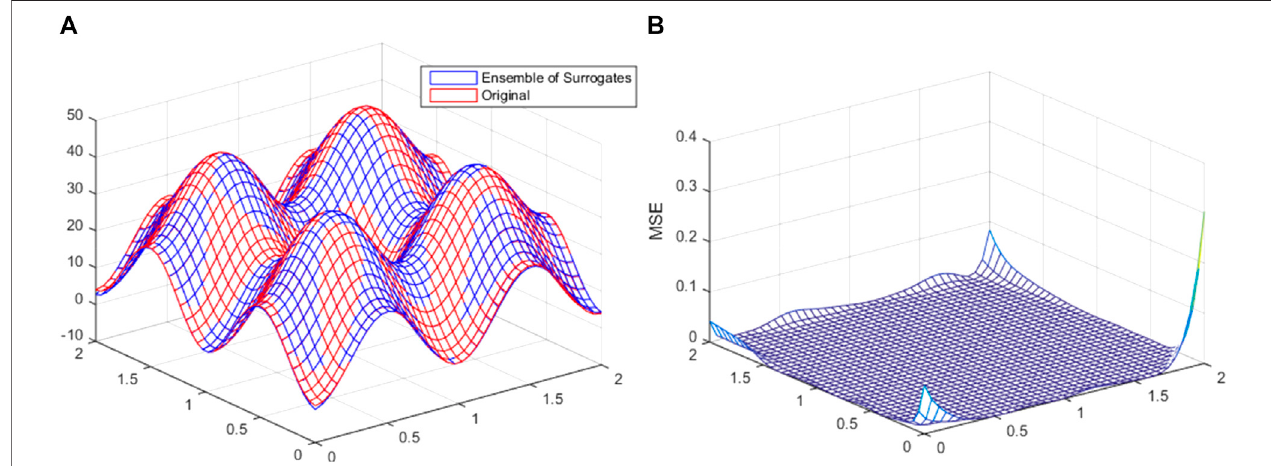
FIGURE 12 | ES. (A) Comparison between the ES and the real function. (B) Mean square error (MSE).